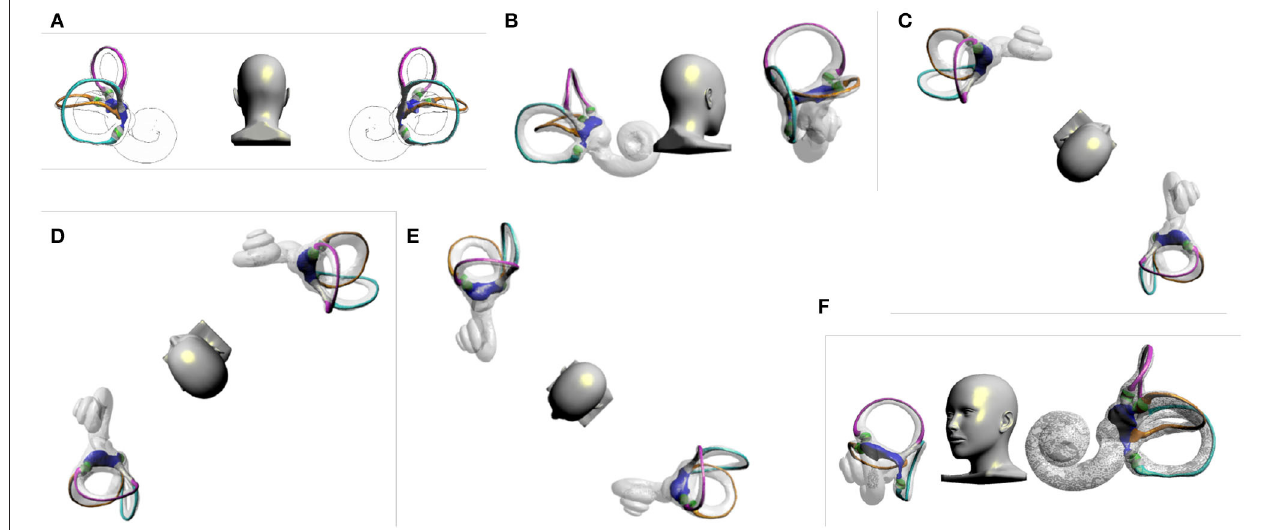
FIGURE 1 | Right Epley maneuver. (A) Upright position. (B) Head turned 45 to the right. (C) The patient quickly lies back, supine, with his head hanging at 30 ◦ . (D) Head turns 90 ◦ to the left. (E) Head continues to turn 90 ◦ to the left. (F) Return to sitting position.